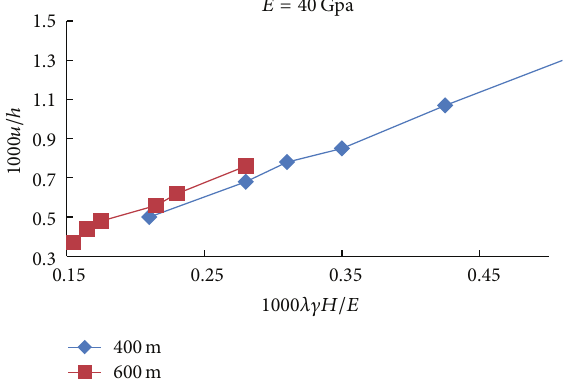
Figure 17: Plastic volume versus lateral pressure coefficient in cases 1 and 2 .